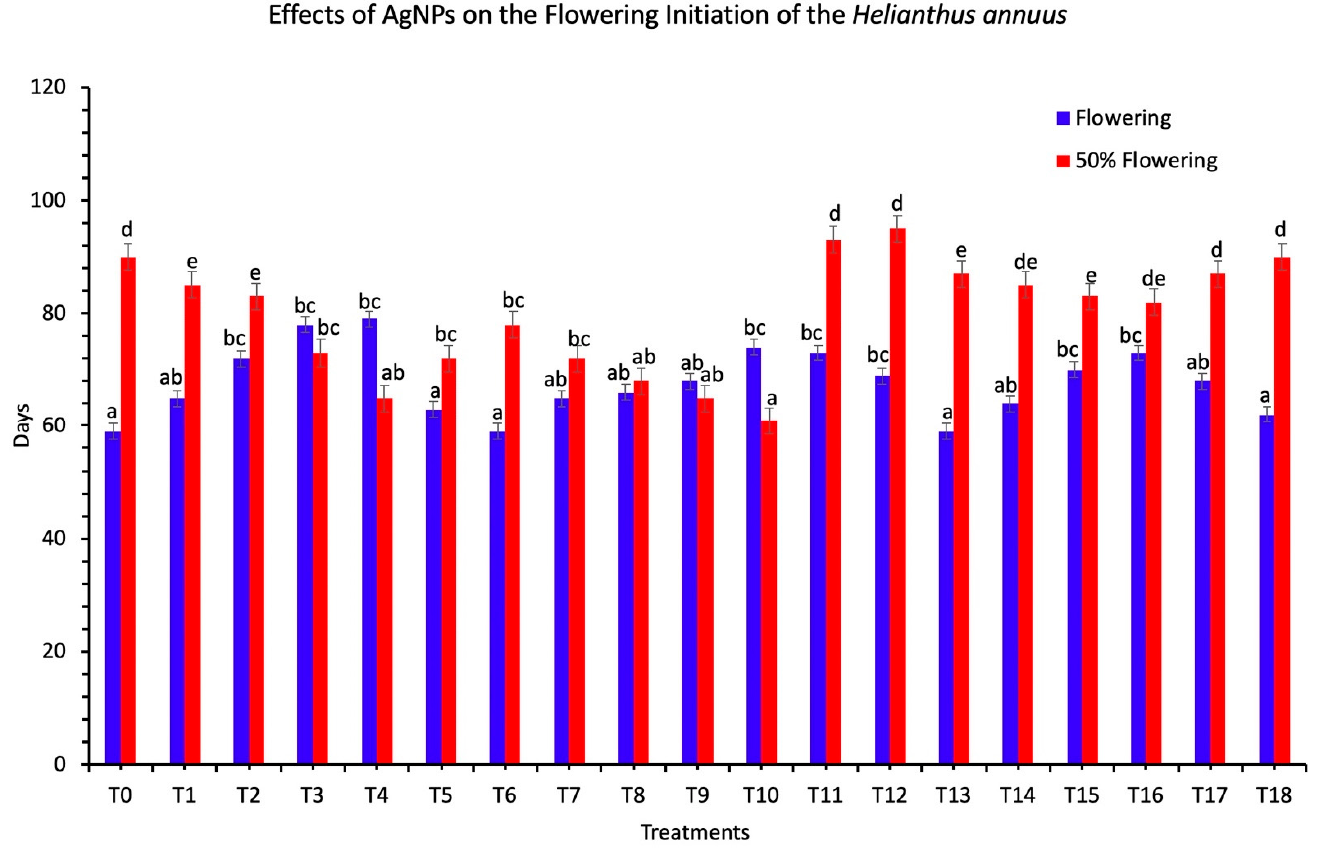
Figure 3. Effects of different treatments of AgNPs on sunflower flowering initiation. Lowercase letters differed significantly at 5% probability levels, using Duncan’s Multiple Range Test ( p < 0.05).